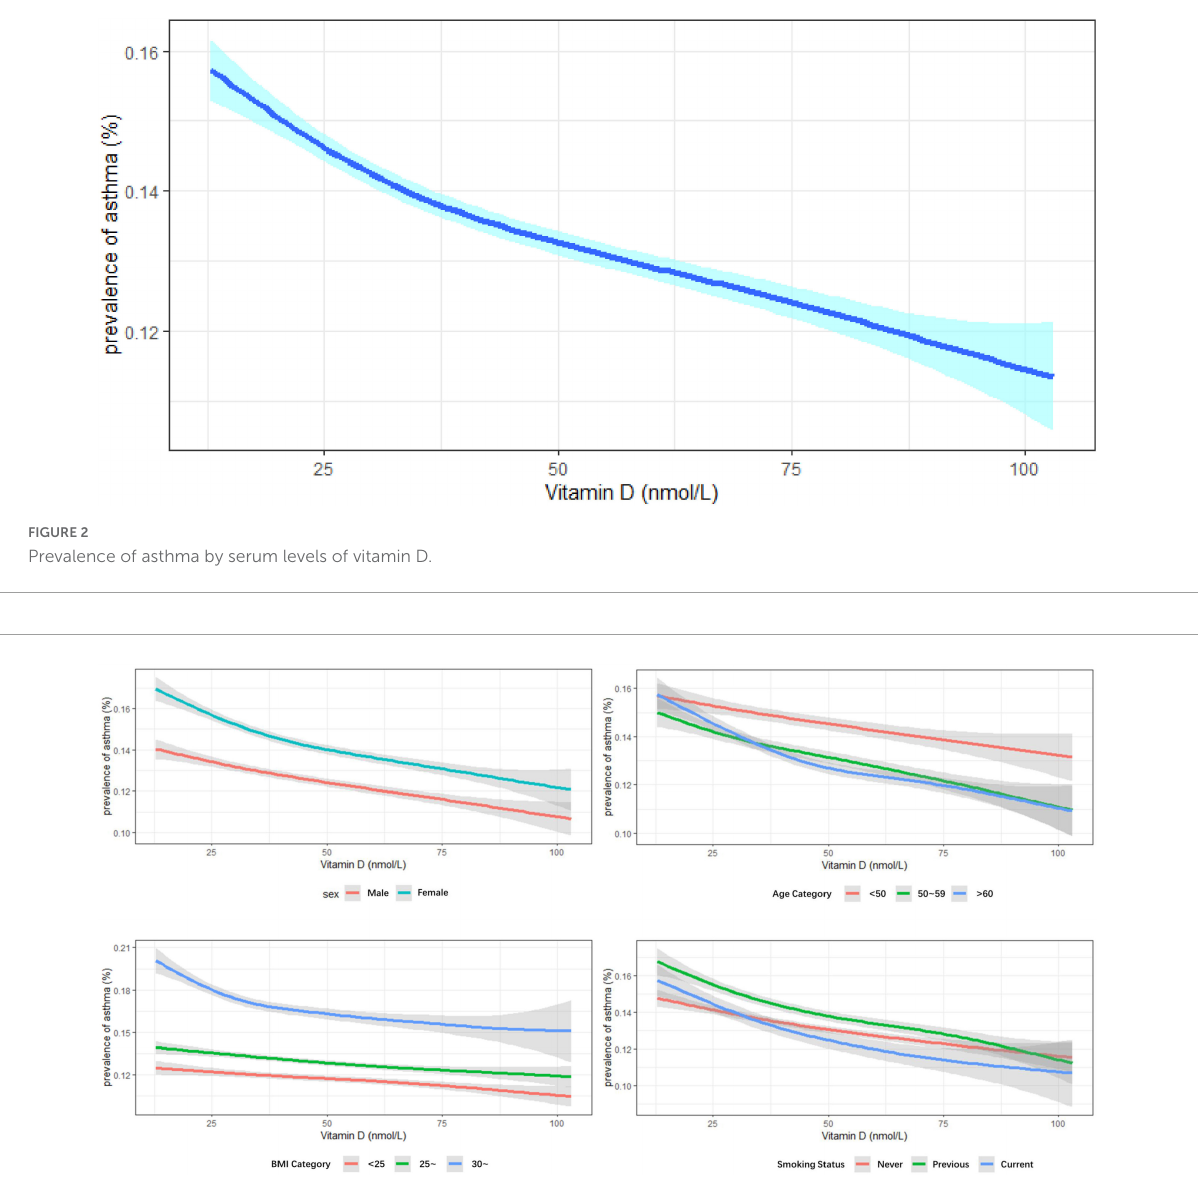
FIGURE3 Multivariable analysis of serum vitamin D levels and prevalence of asthma stratified by sex, age groups, body mass index (BMI) categories, and smoking status.